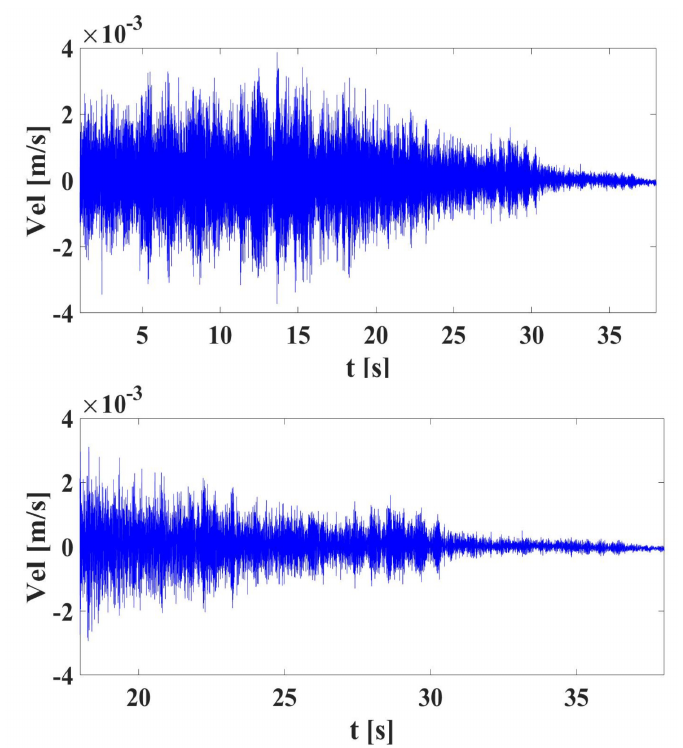
Figure 13. Free decay response in time domain. Complete experiment and decay with fan turned off. In order to derive a method to determine the moment when the algebraic estimator converges to stable calculations, we propose to use a sentinel variable that has a known value of 1, as shown in Figure 14. This unitary variable comes from the characteristic polynomial (11), where the N − th power coefficient of the complex variable s precisely equals